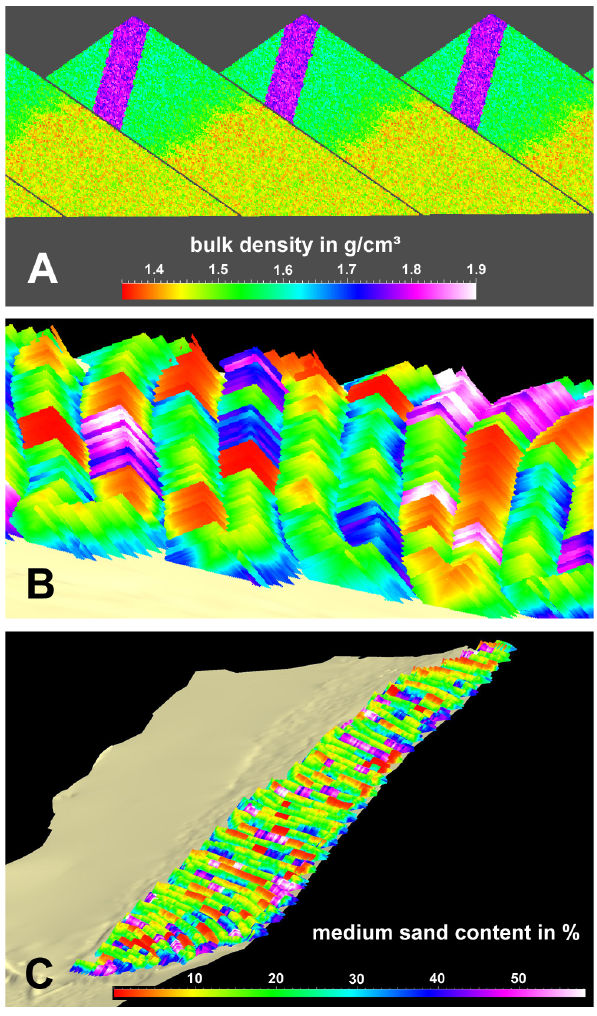
Fig. 10. Structure generator results shown as colour-coded 3-D point data in GOCAD. (A) Cross-section of a single spoil cone, featuring a compacted central zone; (B) side view of several spoil ridges, showing the lateral alignment of single cones; (C) spoil ridges on the complete eastern half of “Chicken Creek”.